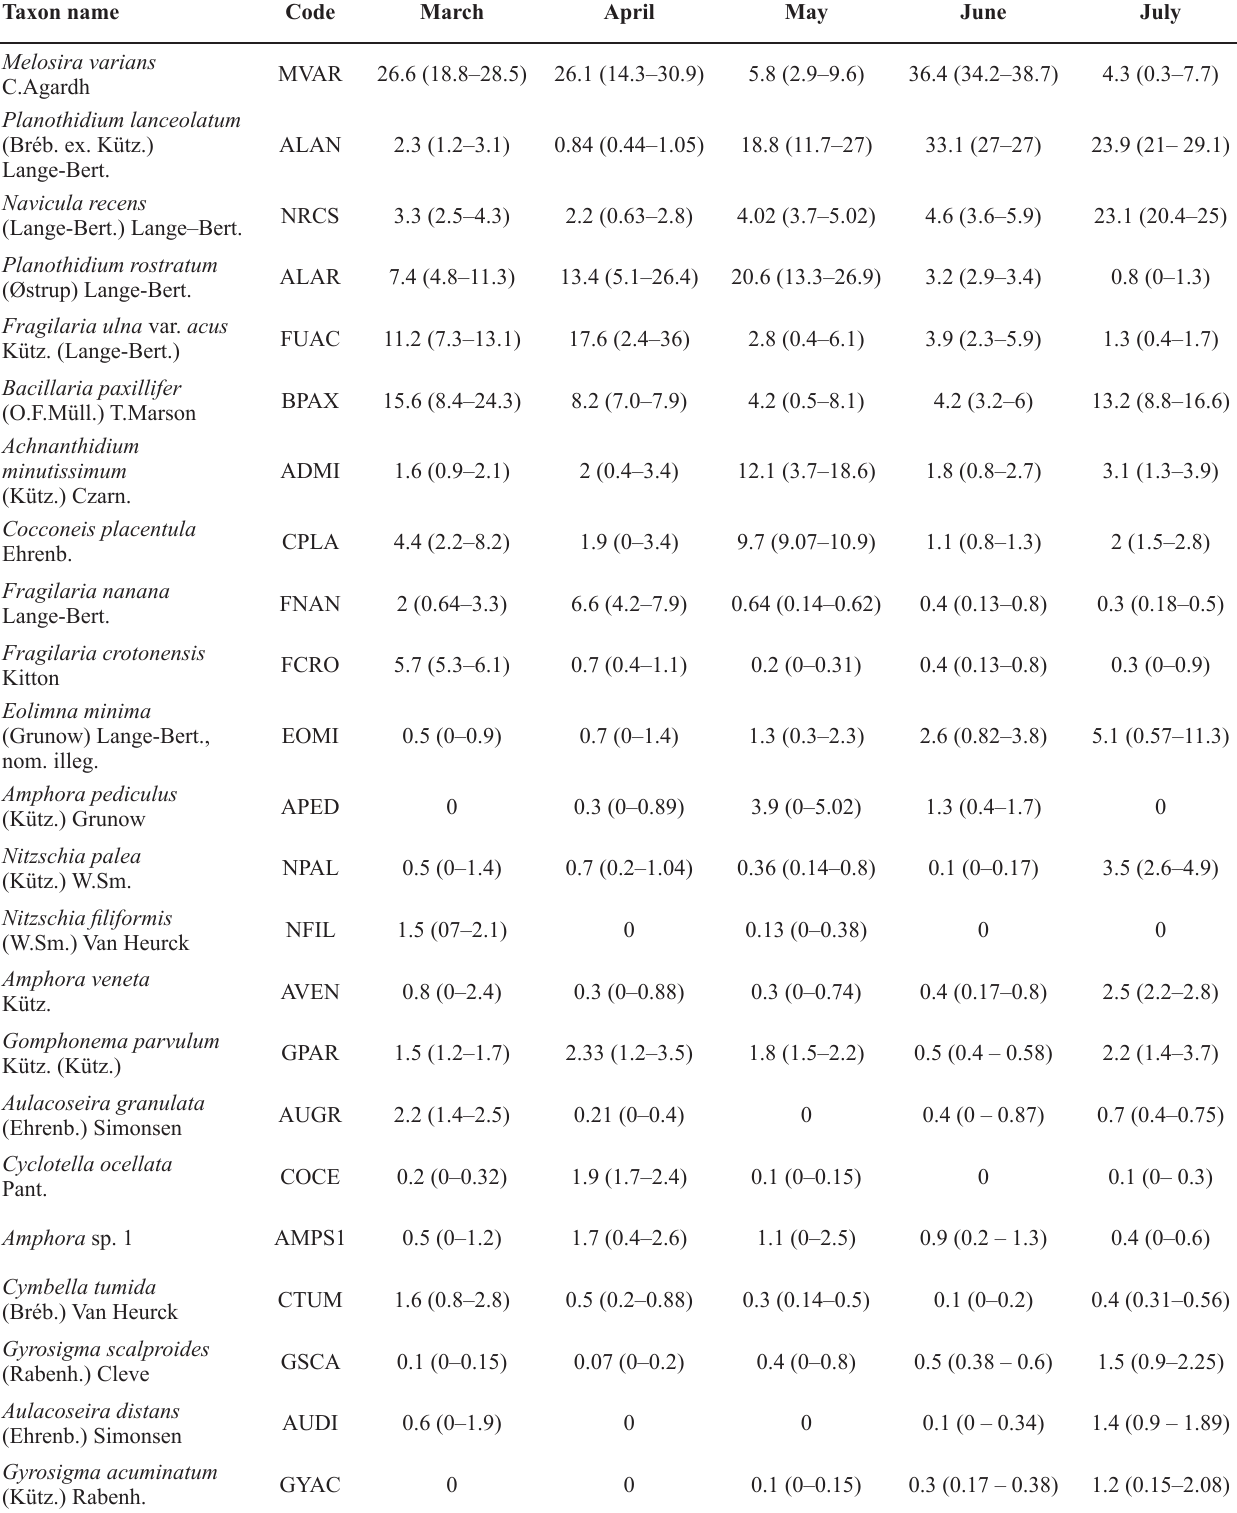
Table 2 – Diatom taxa in biofilm samples collected from Hanoi station (Red River) during the study period from 23 Feb. to 19 Jul. 2018. Percentage average data are presented for each species with minimum and maximum occurrences in parentheses. (> 1% abundance in the diatom assemblage) (average values and minimum –maximum